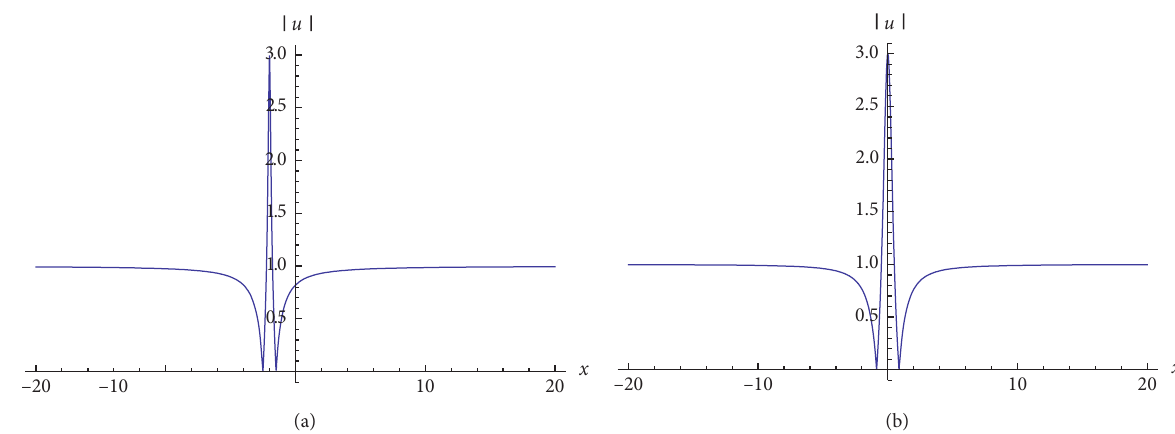
Figure 4: Amplitudes of first-order fractional rogue wave solution (33) and its comparison with the integer order. (a) α � 5/7, a � − 2, and t � − 2. (b) α � 1, a � 0, and t � 0.